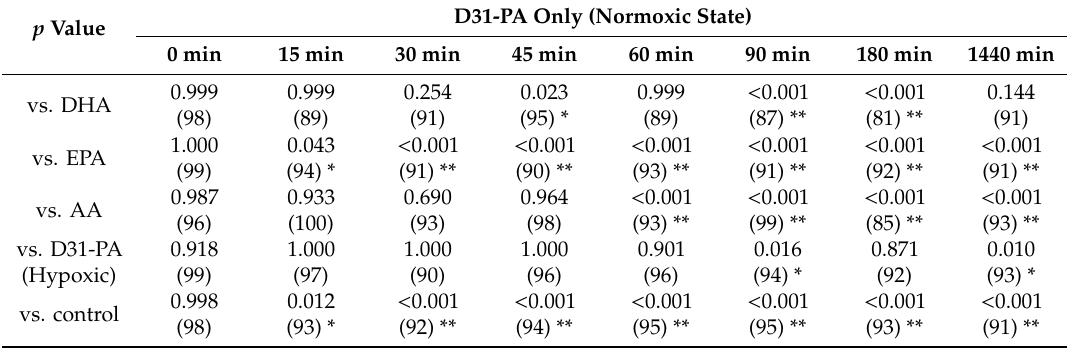
Table 1. The p values of the two-tailed t -tests comparing the D31-PA uptake of cells treated with D31-PA-only and other treatments. * is significant at 0.05 confidence level and ** is at 0.01 confidence level. n values are shown in the